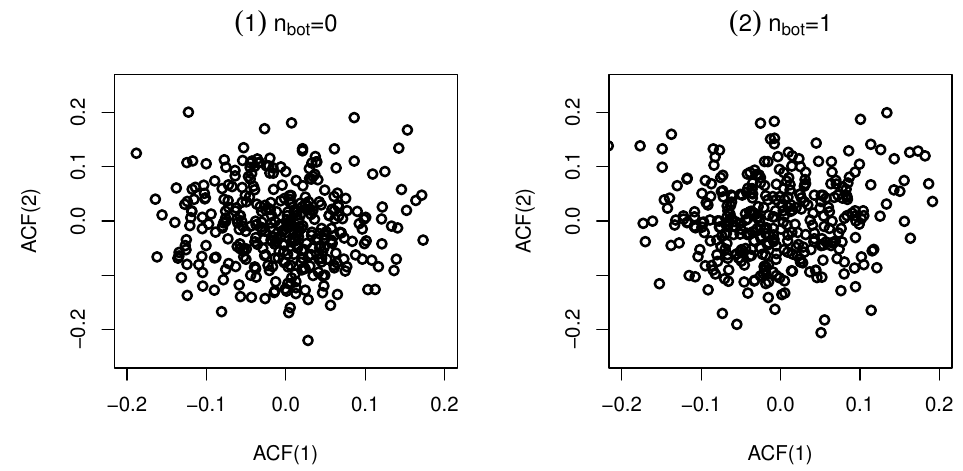
Figure 6. Plots of attainable pairs of ACF(2) against ACF(1) for n top = 2 with c = 0.01. To be honest, the merit of the model ScDBGARCH goes beyond allowing negative auto-regression, and also allowing under-dispersion. To account for the dispersion, we present the plots of the BID (in Figures 7 and 8) for the ScDBGARCH(1,1) model, for given = 0 or 1, sample size T = 200 and τ = 1 when α n top = 10 or 2 and n 1 is varying from bot − 0.9 to 0.9 with an increment 0.1, β = 0.05 and w = 0.5 ( 1 − | α | − | β | ) . 1 1 1